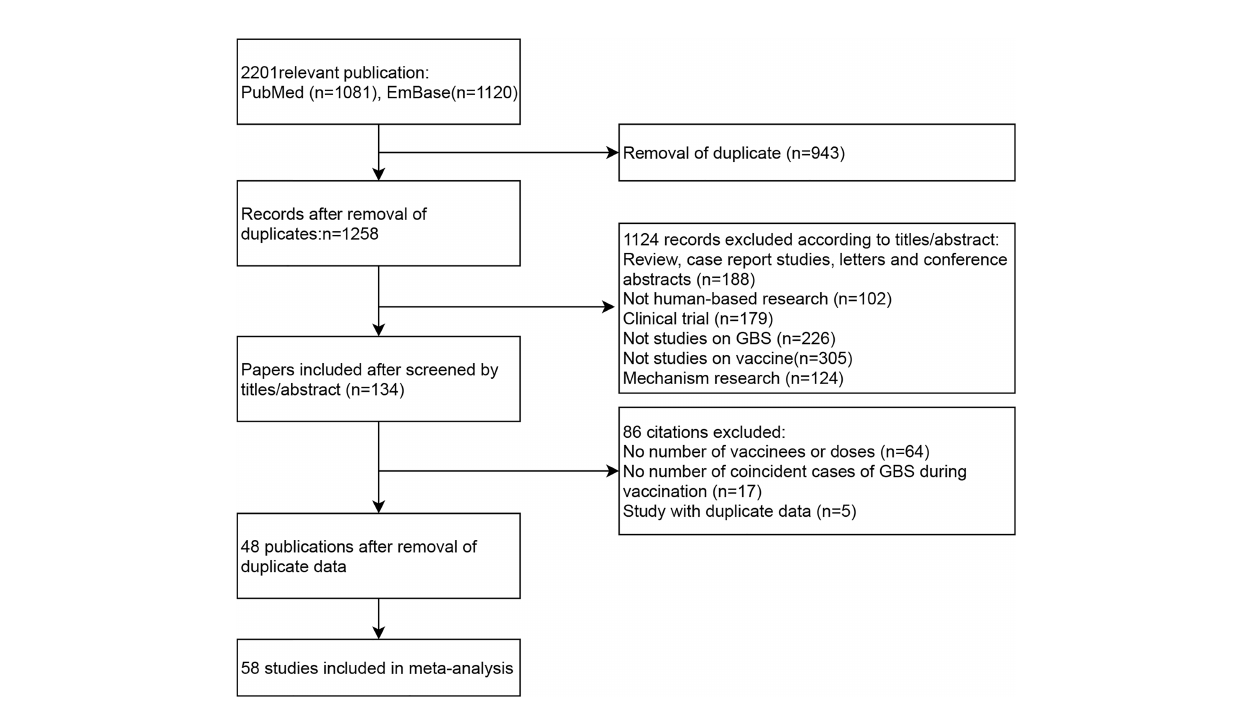
FIGURE 1 | Flow diagram of study